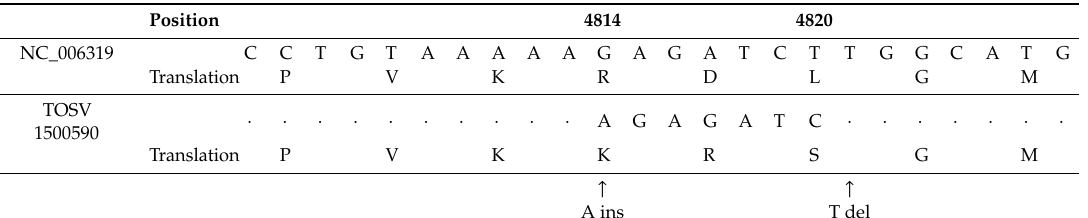
Table A1. RNA sequencing of L revealed a single insertion and deletion in the TOSV reference sequence at 4814 to 4820 in the GenBank TOSV sequence NC_006319 when compared with TOSV 1500590, changing the protein sequence.